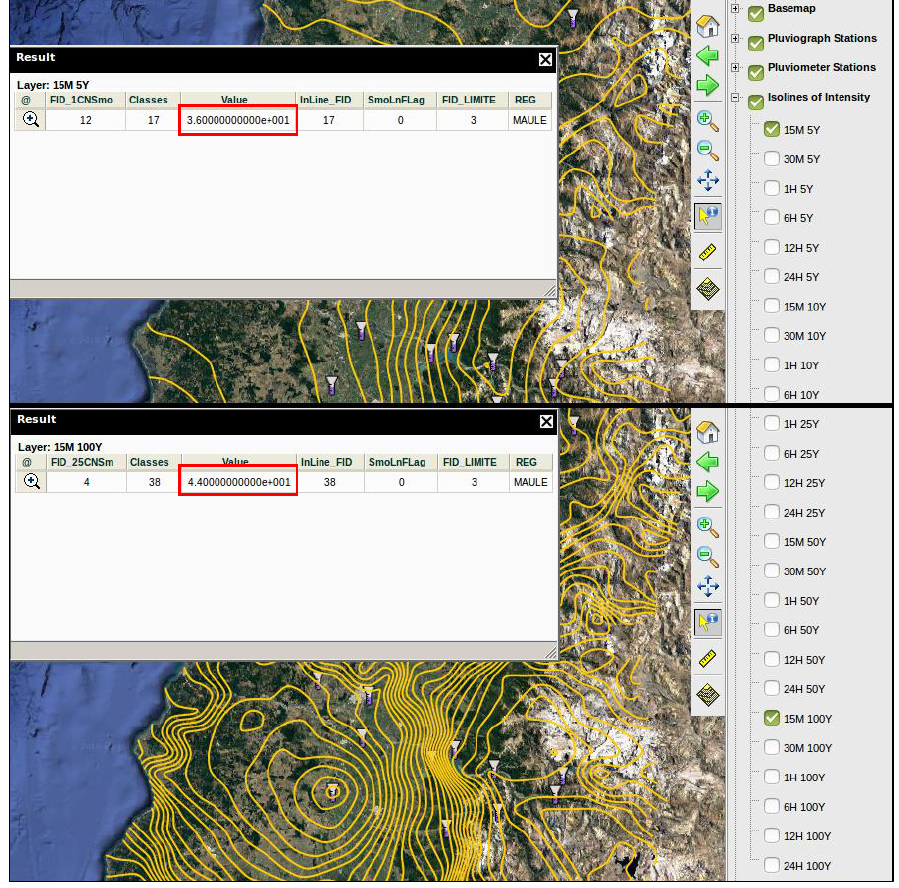
Figure 12. Isolines of maximum rainfall intensity for D = 15 minutes associated with ( a ) T = 5 years; and with ( b ) T = 100 years in WEBSE IDF using ordinary Kriging interpolation. The interpolated value for each frequency is shown in the red boxes.